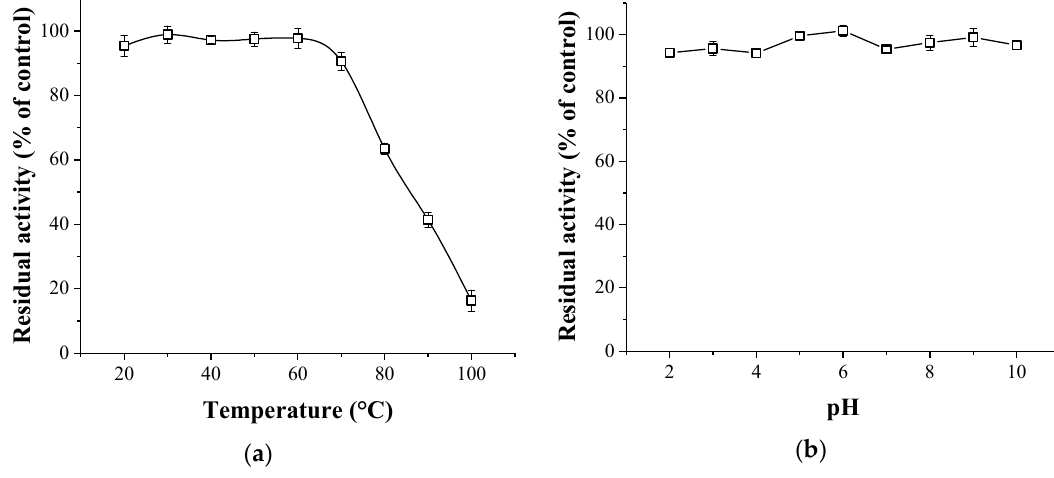
Figure 5. Thermal stability ( a ) and pH stability ( b ) of PHTI.